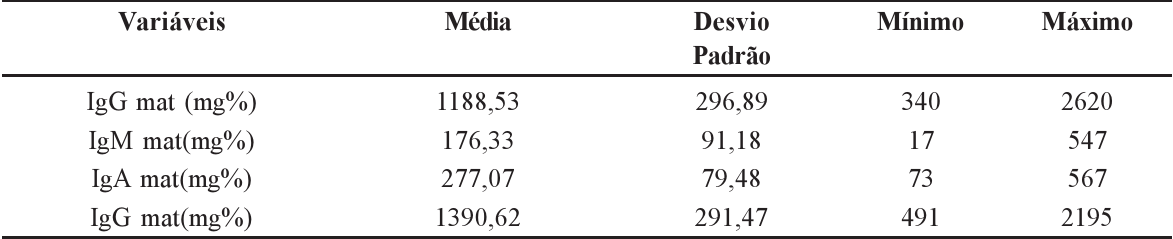
Concentra(cid:231)ıes de TABELA 6 (cid:150) MØdia aritmØtica, desvio padrªo, valores m(cid:237)nimo e mÆximo de 644 soros, sendo 321 soros de mªes e 323 de RN.